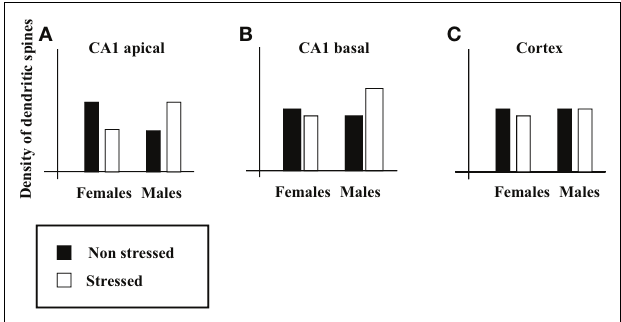
FIGURE 1 | Illustration of the effects of acute stress on sex differences in density of dendritic spines. Illustrations of (A,B) the density of the apical (A) and basal (B) dendritic spines on pyramidal neurons in CA1, and (C) the density of dendritic spines in somatosensory cortex (on the basis of Figure 4 in Shors et al.,